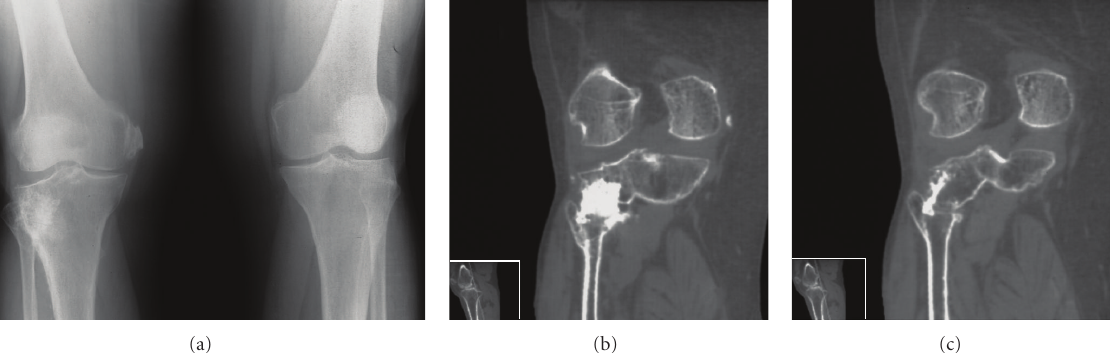
Figure 3: AP radiograph of both knees (a), and CT (b,c) examination in a 69-year-old woman, revealing ectopic calcification of the proximal TFJ of the right